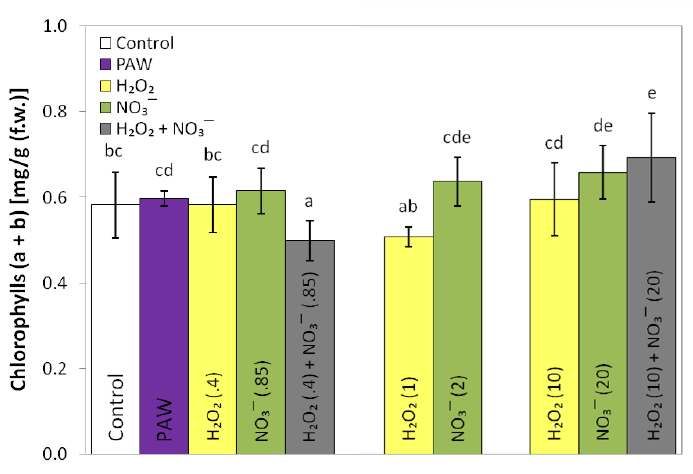
Figure 4. Chlorophyll (a + b) content in above-ground parts of lettuce plants after 5 weeks of soil cultivation irrigated with the plasma activated water (PAW), solutions of various concentrations of H 2 O 2 (0.4, 1, 10 mM), NO 3− (0.85, 2, 20 mM), H 2 O 2 + NO 3− (0.4 mM + 0.85 mM, 10 mM + 20 mM), and control irrigated with tap water. The data are presented as mean values ± standard deviation from 3 independent repetitions. The lowercase letters represent statistically significant difference at probability p < 0.05.